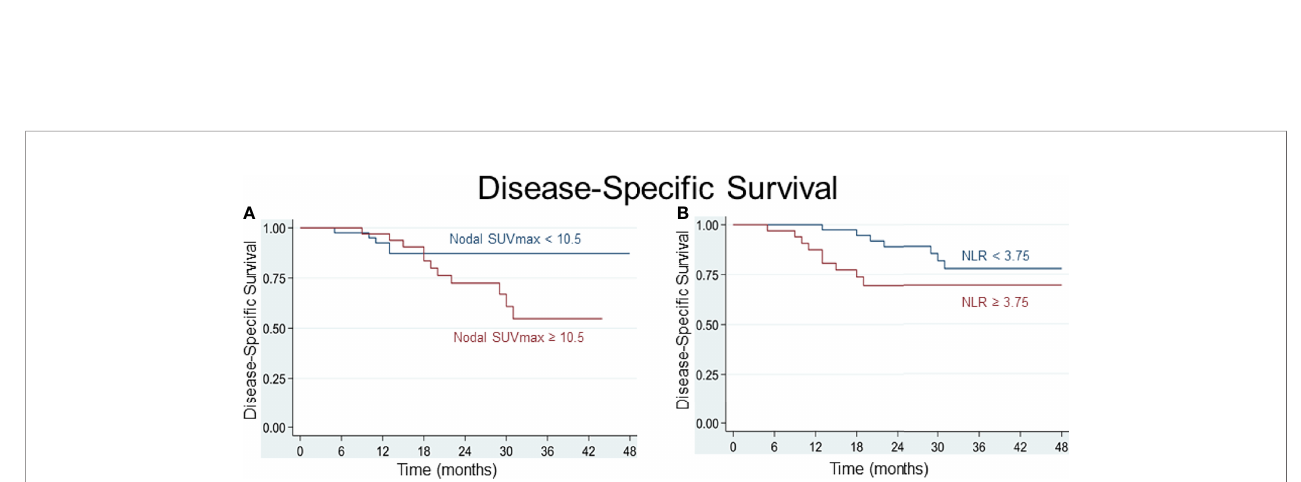
FIGURE 2 | Example of a cT4 cN2c cM0 hypopharyngeal carcinoma in a 62-year-old male patient. He developed locoregional tumor recurrence with distant metastases and died 13 months after completion of radiochemotherapy. (A) Axial and (B) coronal view of fused PET/CT image of nodal metastasis.